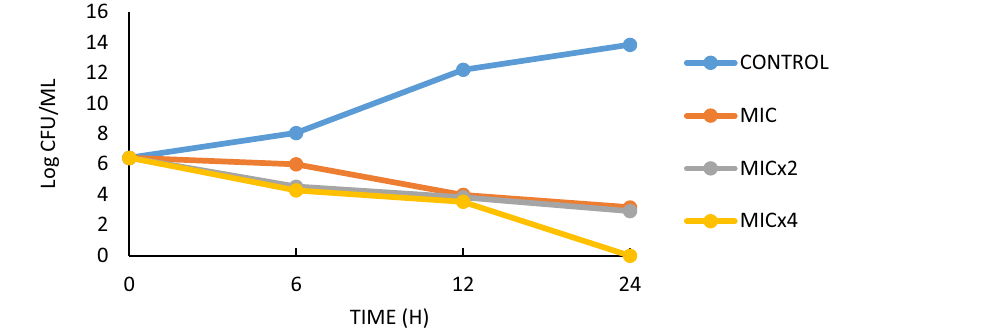
Figure 5. Effect of 4b on S. aureus .